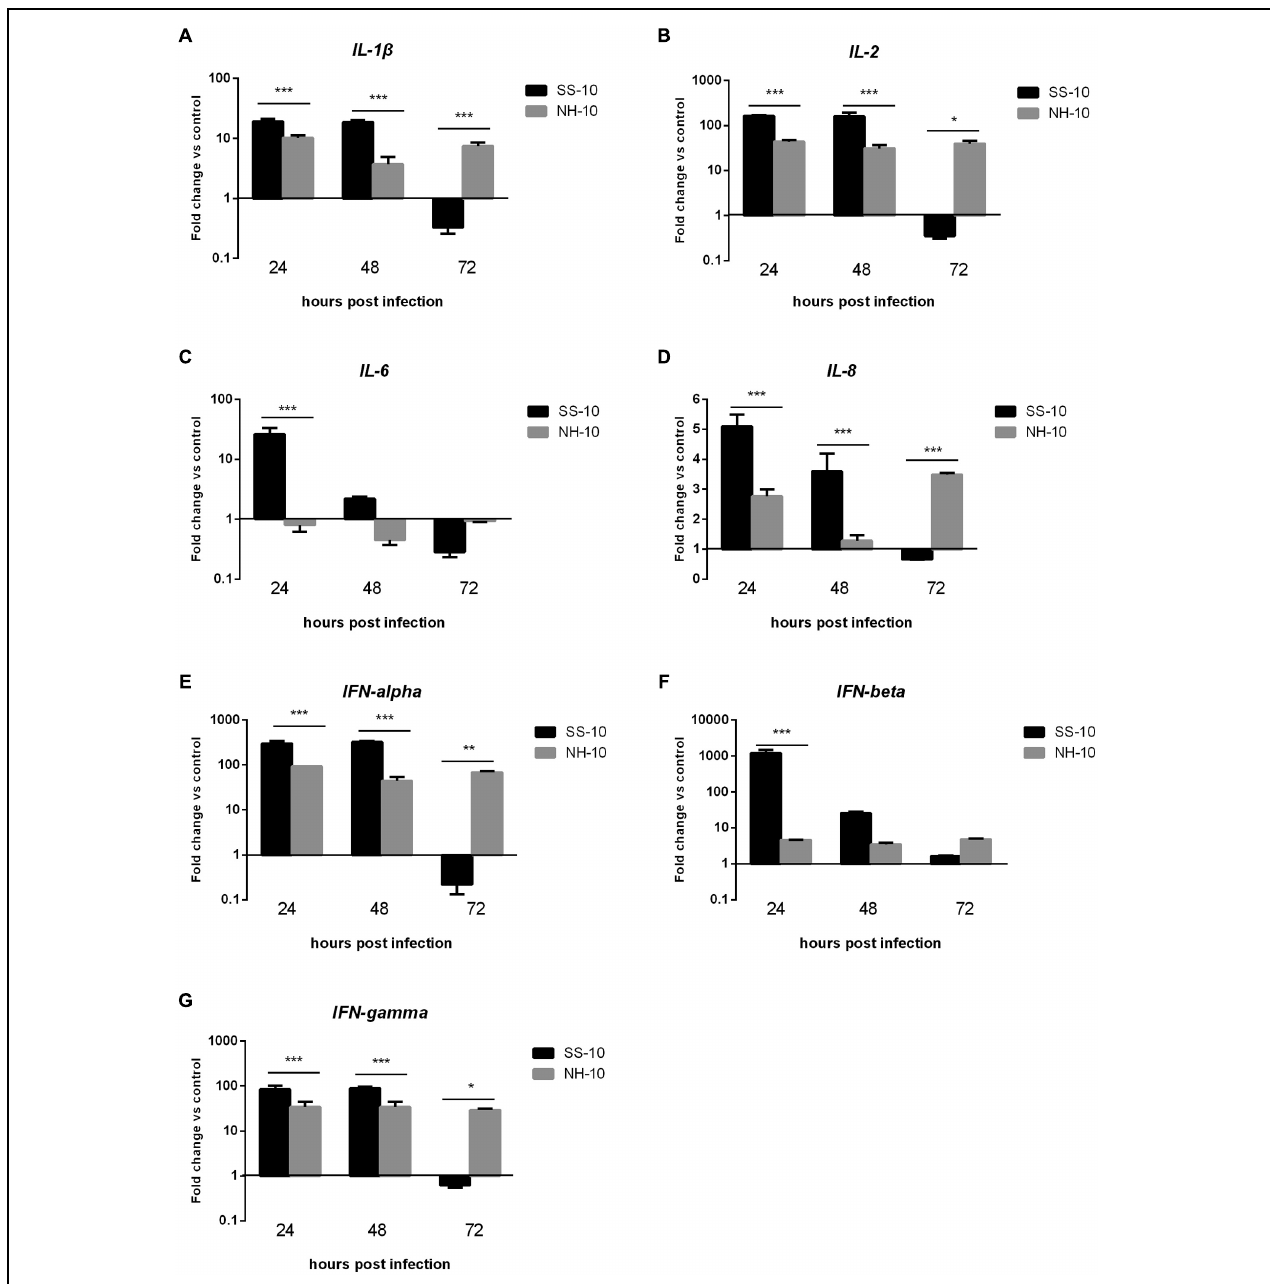
FIGURE 4 | Fold change expression of cytokines in the lungs of infected ducks in response to SS-10 and NH-10. (A) IL-1 β , (B) IL-2 , (C) IL-6 , (D) IL-8 , (E) IFN-alpha , (F) IFN-beta , (G) IFN-gamma . The Y -axis represents the fold change in target gene expression in the experimental group relative to those in the control group and presented as the mean values ± standard deviation ( n = 3). Significance is analyzed with two-way ANOVAs between SS-10 group and NH-10 group at the same time points ( ∗ p < 0.05, ∗∗ p < 0.01, ∗∗∗ p < 0.001). Error bars indicate standard